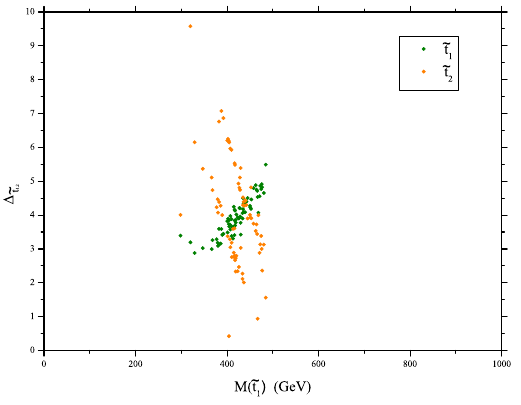
Figure 6 . Electroweak fine-tuning measure ∆ e function of M